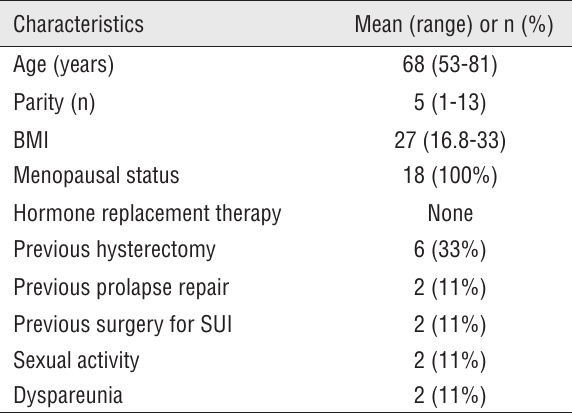
Table 1 - Pre-operative patient’s